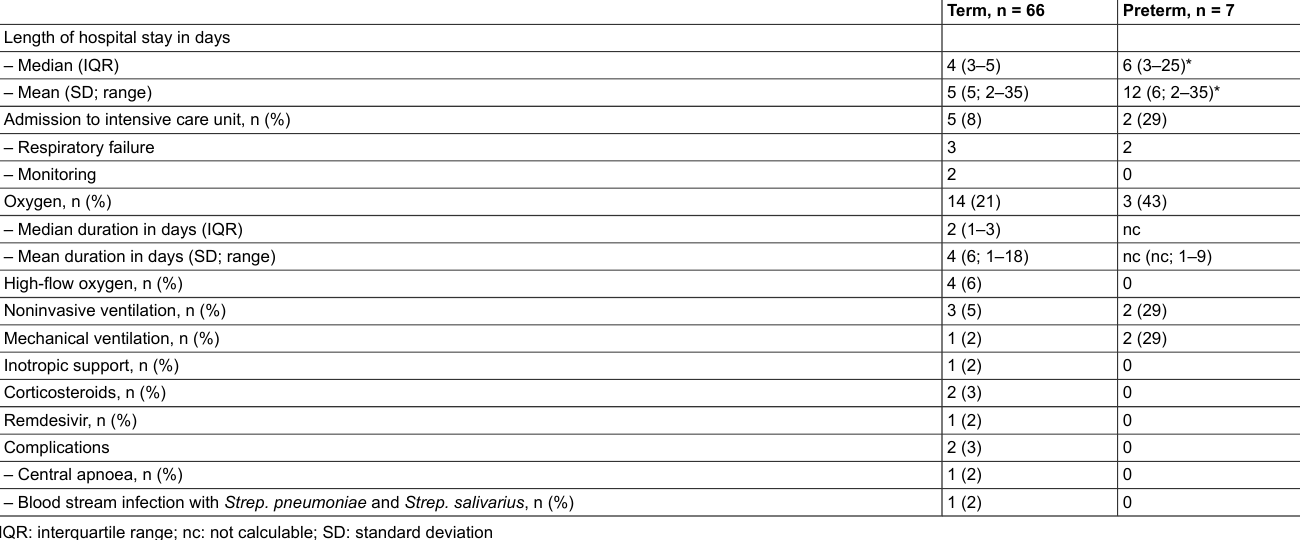
Table 3: Admission, treatment and complications in neonates with SARS-CoV-2